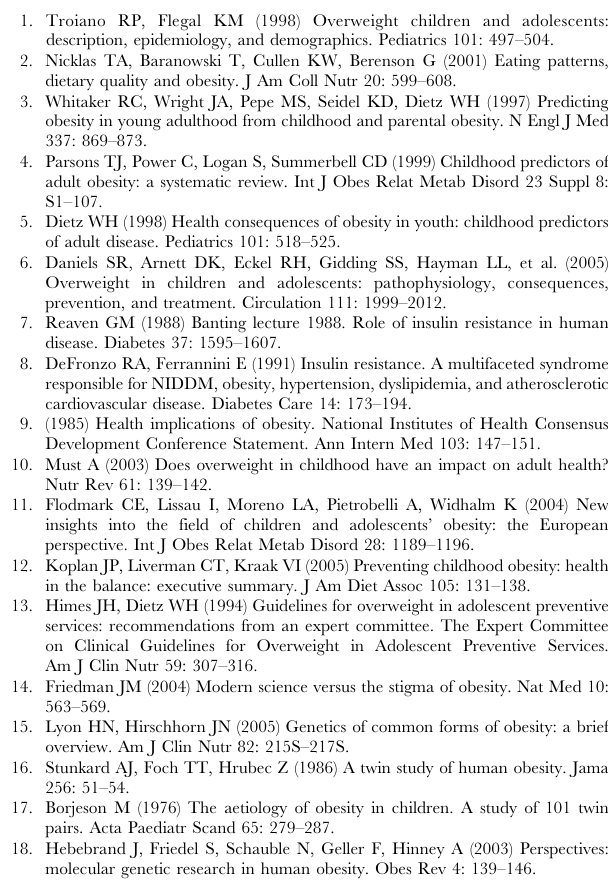
Table S1 Haplotype frequencies in the Caucasian study cohort